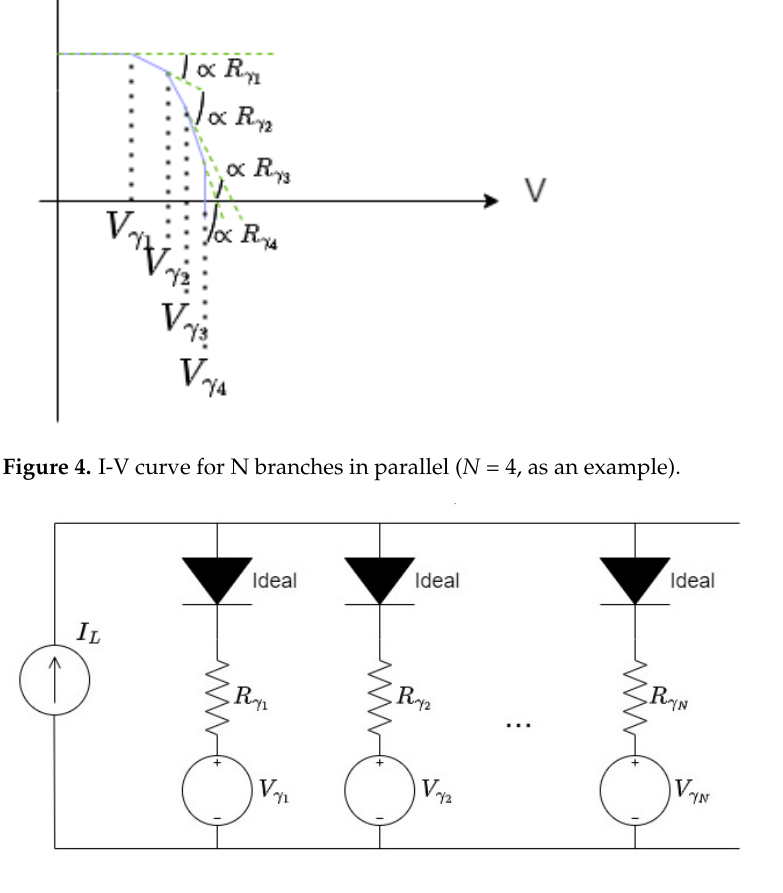
Figure 5. Proposed equivalent circuit model of a photovoltaic solar cell: